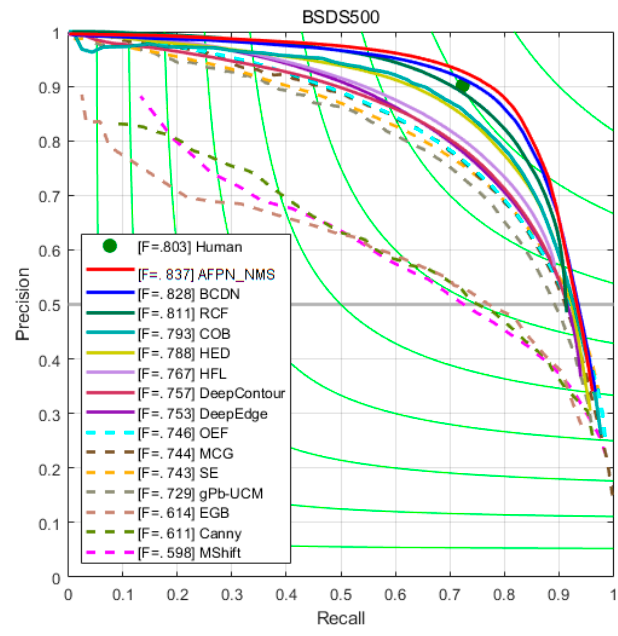
Figure 4. The evaluation results standard BSDS500 dataset.